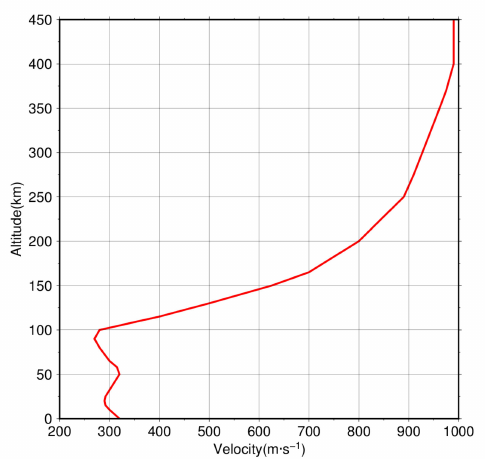
Figure 15. Wave transmission velocity diagram within 0–450